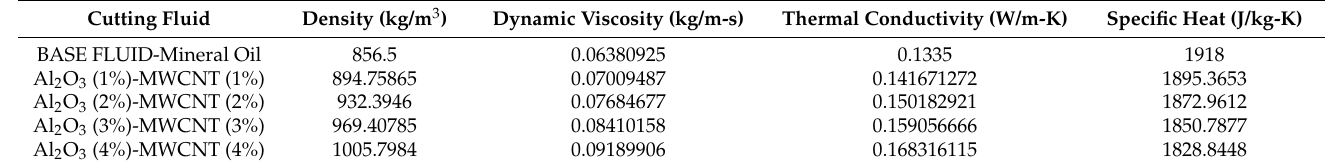
Table 5. Thermophysical and mechanical properties of mineral oil dispersed with Al 2 O 3